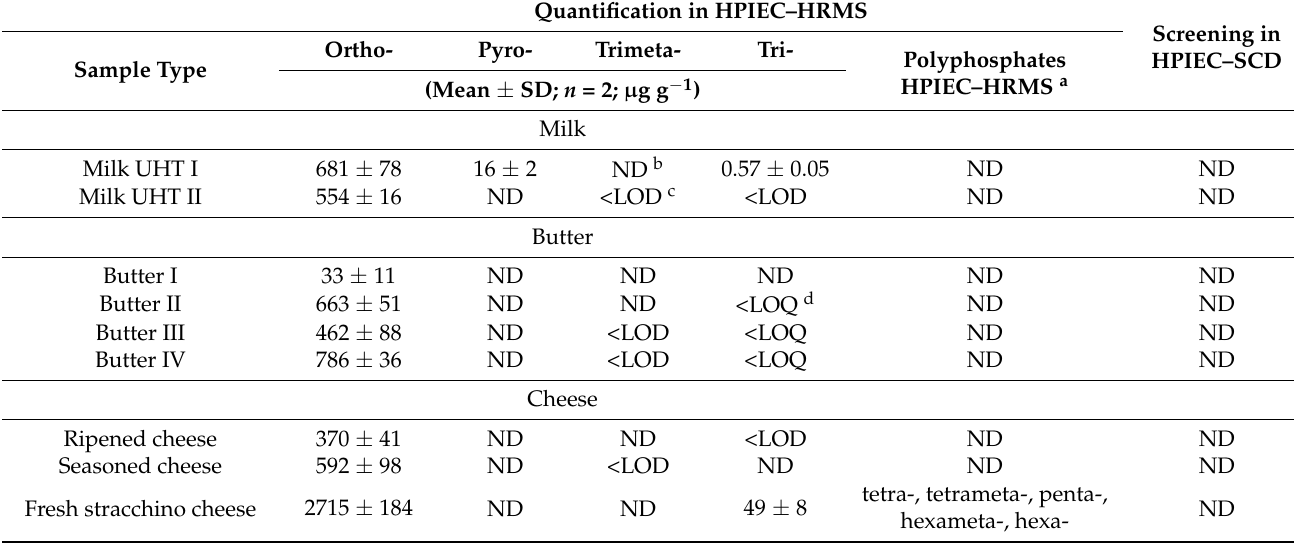
Table 5. (Poly)phosphates in different types of undeclared dairy